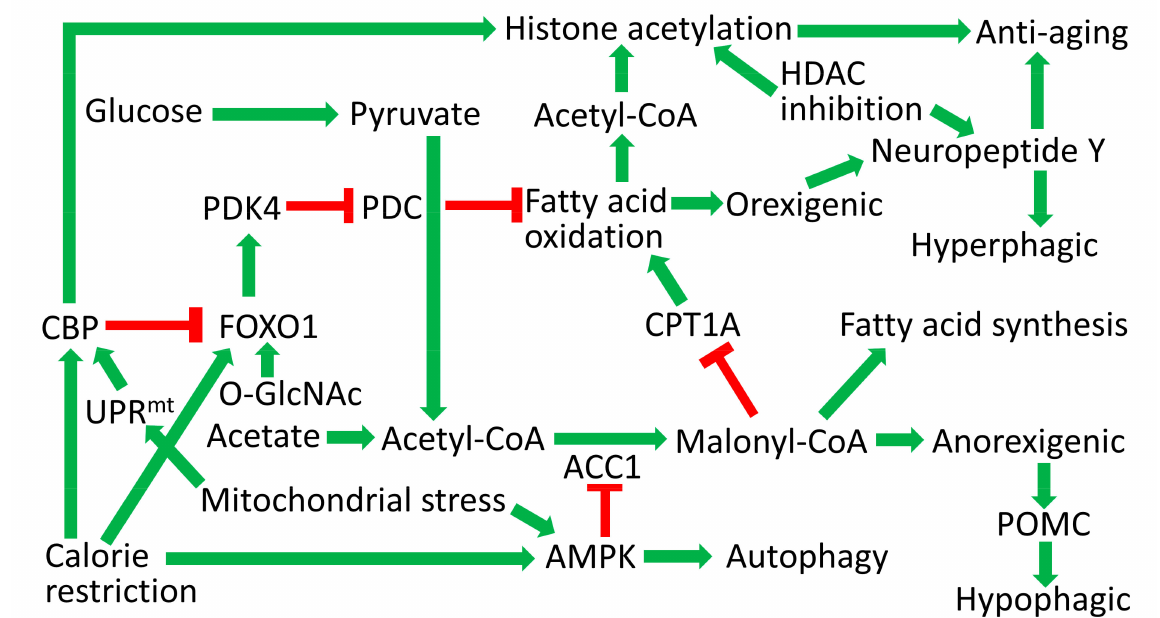
Figure 3. Hypothalamic acetyl-CoA, CBP, and histone acetylation play a central role in regulating organismal energy balance and longevity pathways. Abbreviations: CBP, CREB binding protein; O-GlcNAc, O-linked N-acetyl-glucosaminylation; FOXO1, forkhead box O 1; UPR mt , mitochondrial unfolded protein response; PDK4, pyruvate dehydrogenase kinase 4; PDC, pyruvate dehydrogenase complex; HDAC, histone deacetylase; ACC1, acetyl-CoA carboxylase 1; AMPK, adenosine monophosphate-activated protein kinase; POMC,